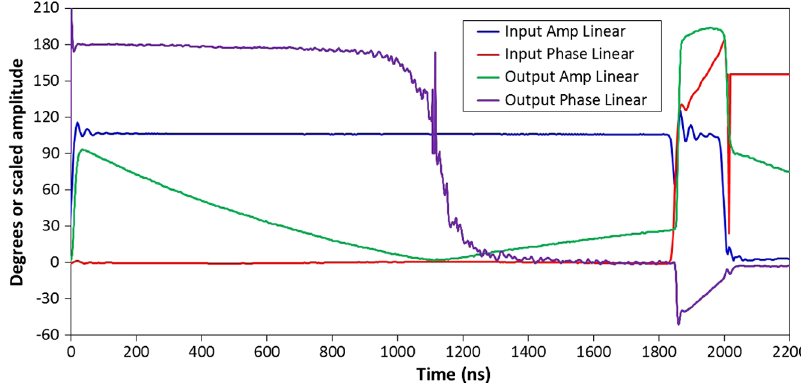
FIG. 14. Measured input and output to and from the pulse compressor at XBOX-3 when a phase switch of 120°, followed by a linear phase ramp is applied to the drive signal to a 7 MW